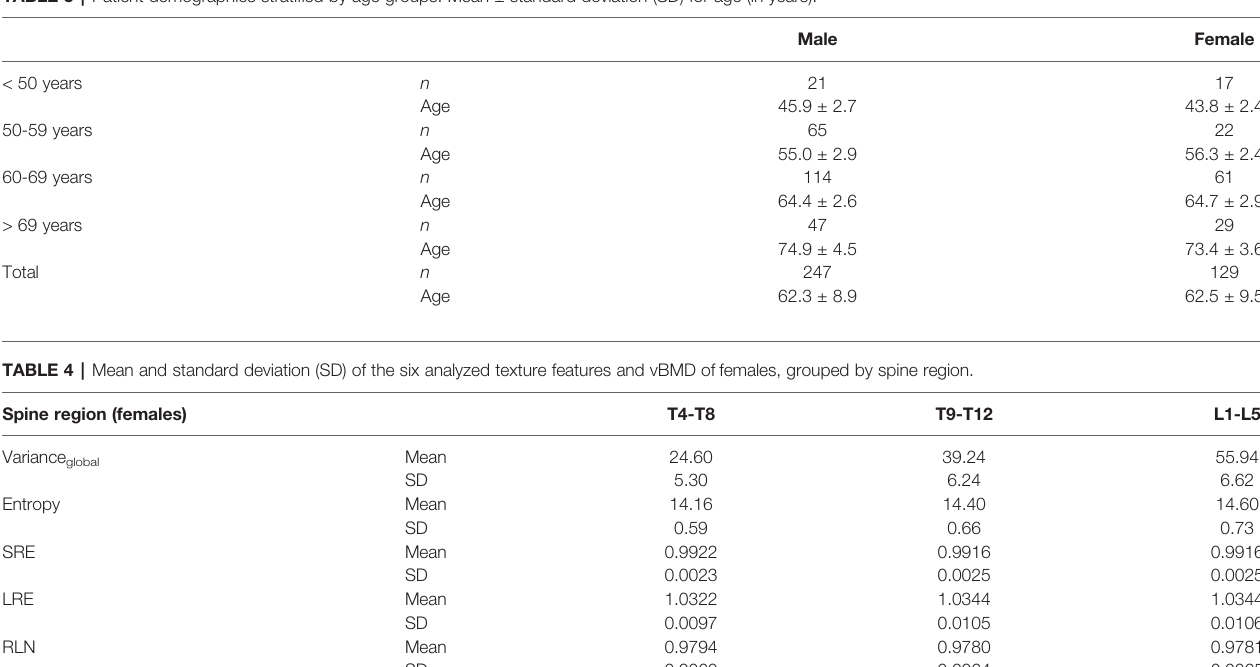
TABLE 3 | Patient demographics strati fi ed by age groups. Mean ± standard deviation (SD) for age (in years).